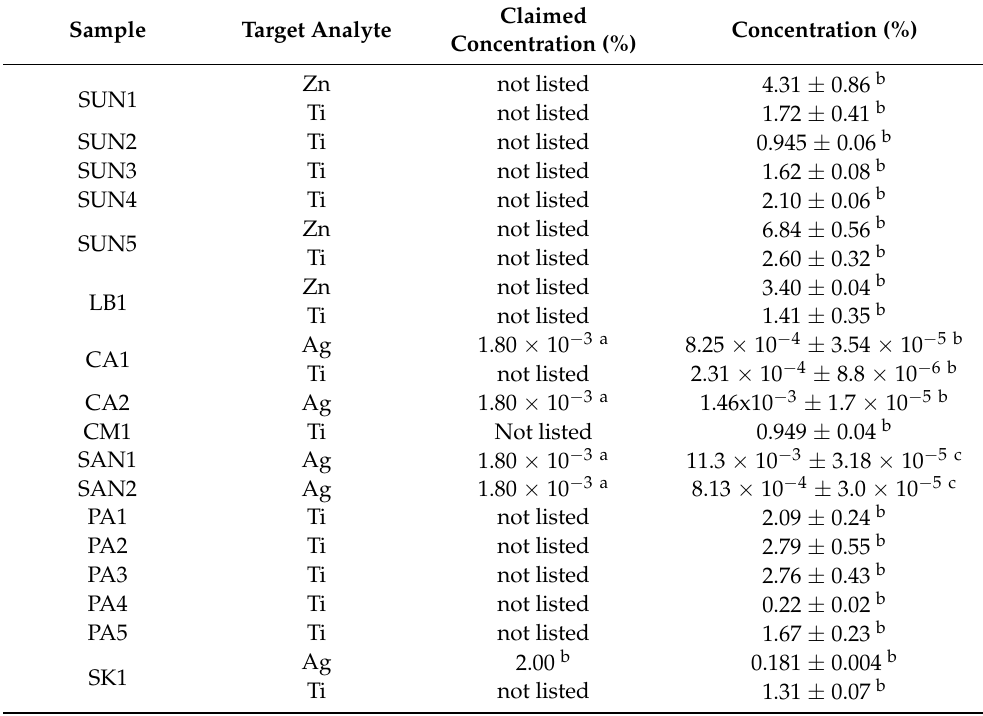
Table 2. The total elemental concentration of the ENMs found in